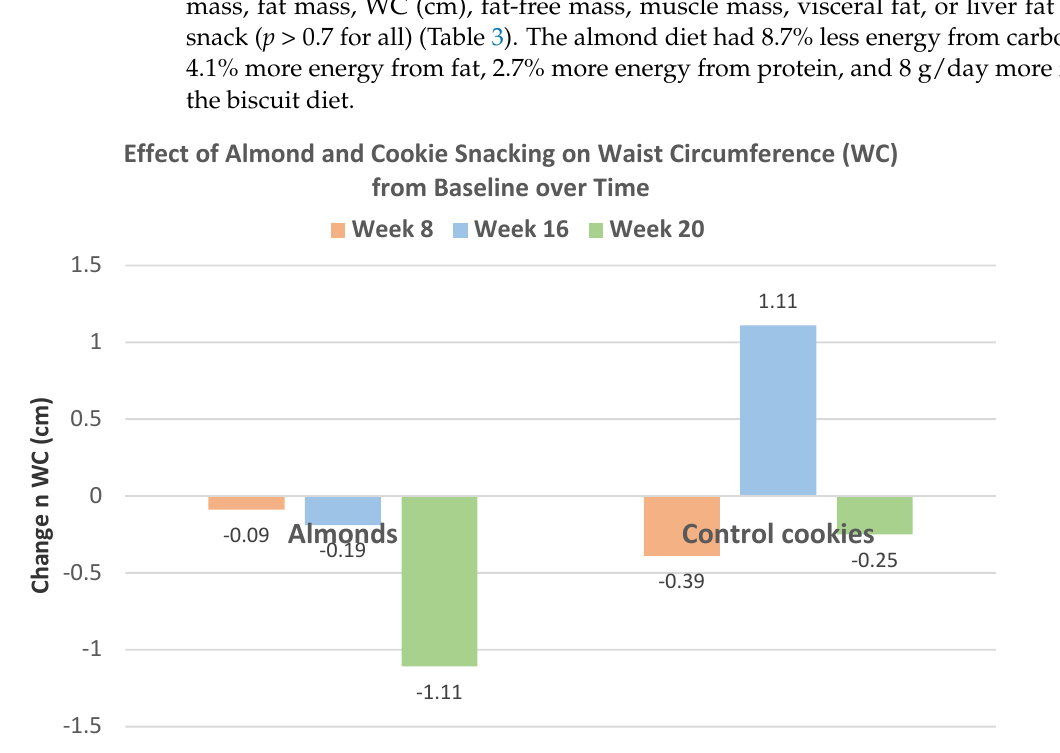
Figure 13. Changes in WC for almonds and control cookies over time (almonds p for time effects = 0.013 [43]. Table 3. Anthropometric changes from baseline to 8 weeks by snack group in older obese adults at risk for or with type 2 diabetes